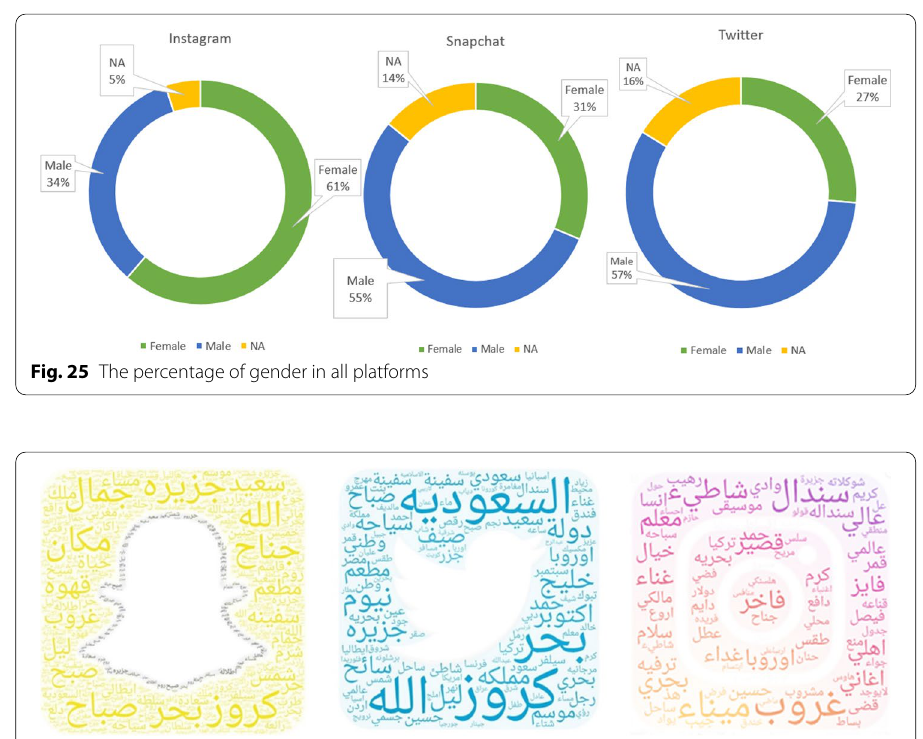
Fig. 26 The word clouds of the